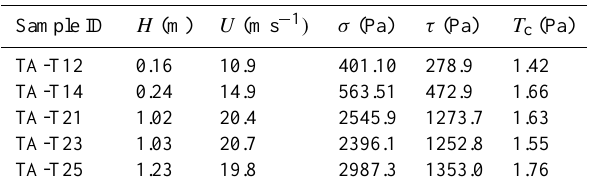
Table 3. Output of the RAMMS avalanche model at the sample points ( H = flow height, U = velocity, σ = normal stress, τ = basal shear stress, T c = critical soil shear stress; TA: track area; RA: re- lease